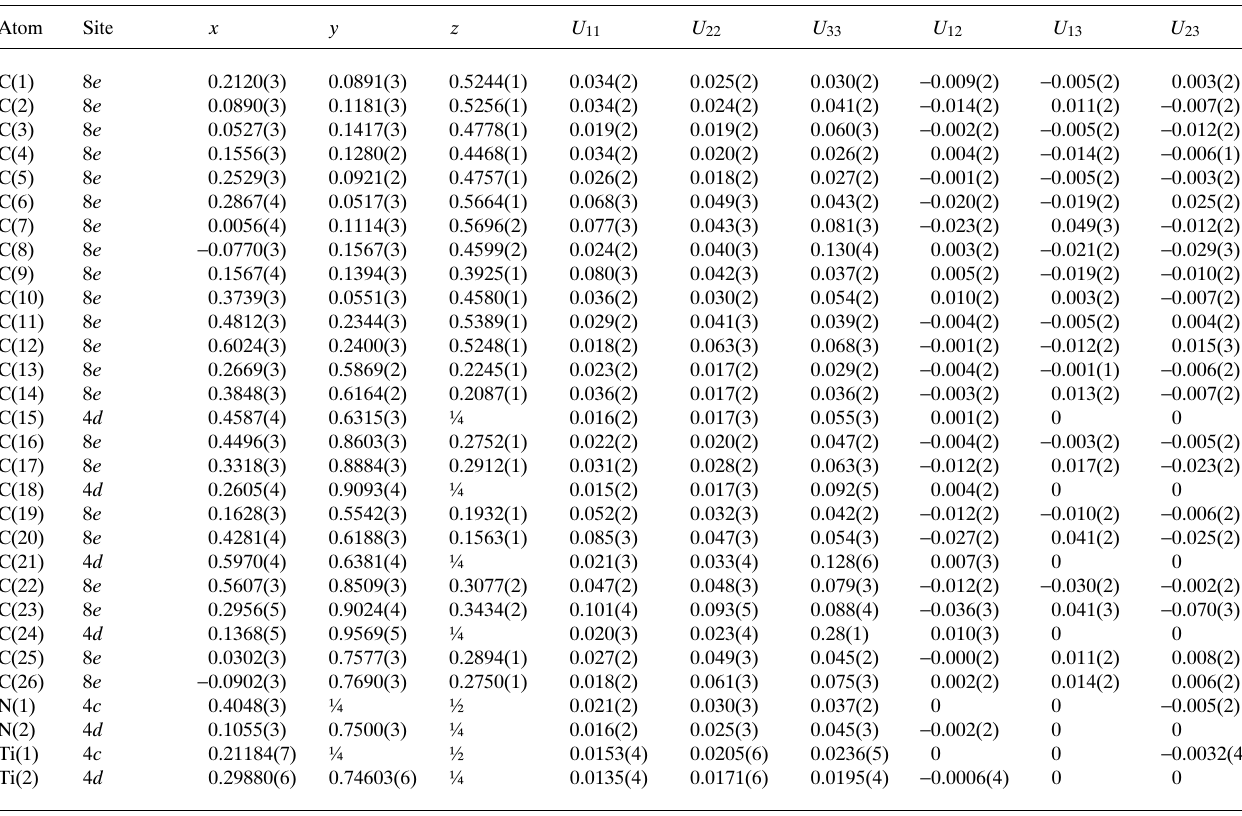
Table 3. Atomic coordinates and displacement parameters (in Å 2 ) .